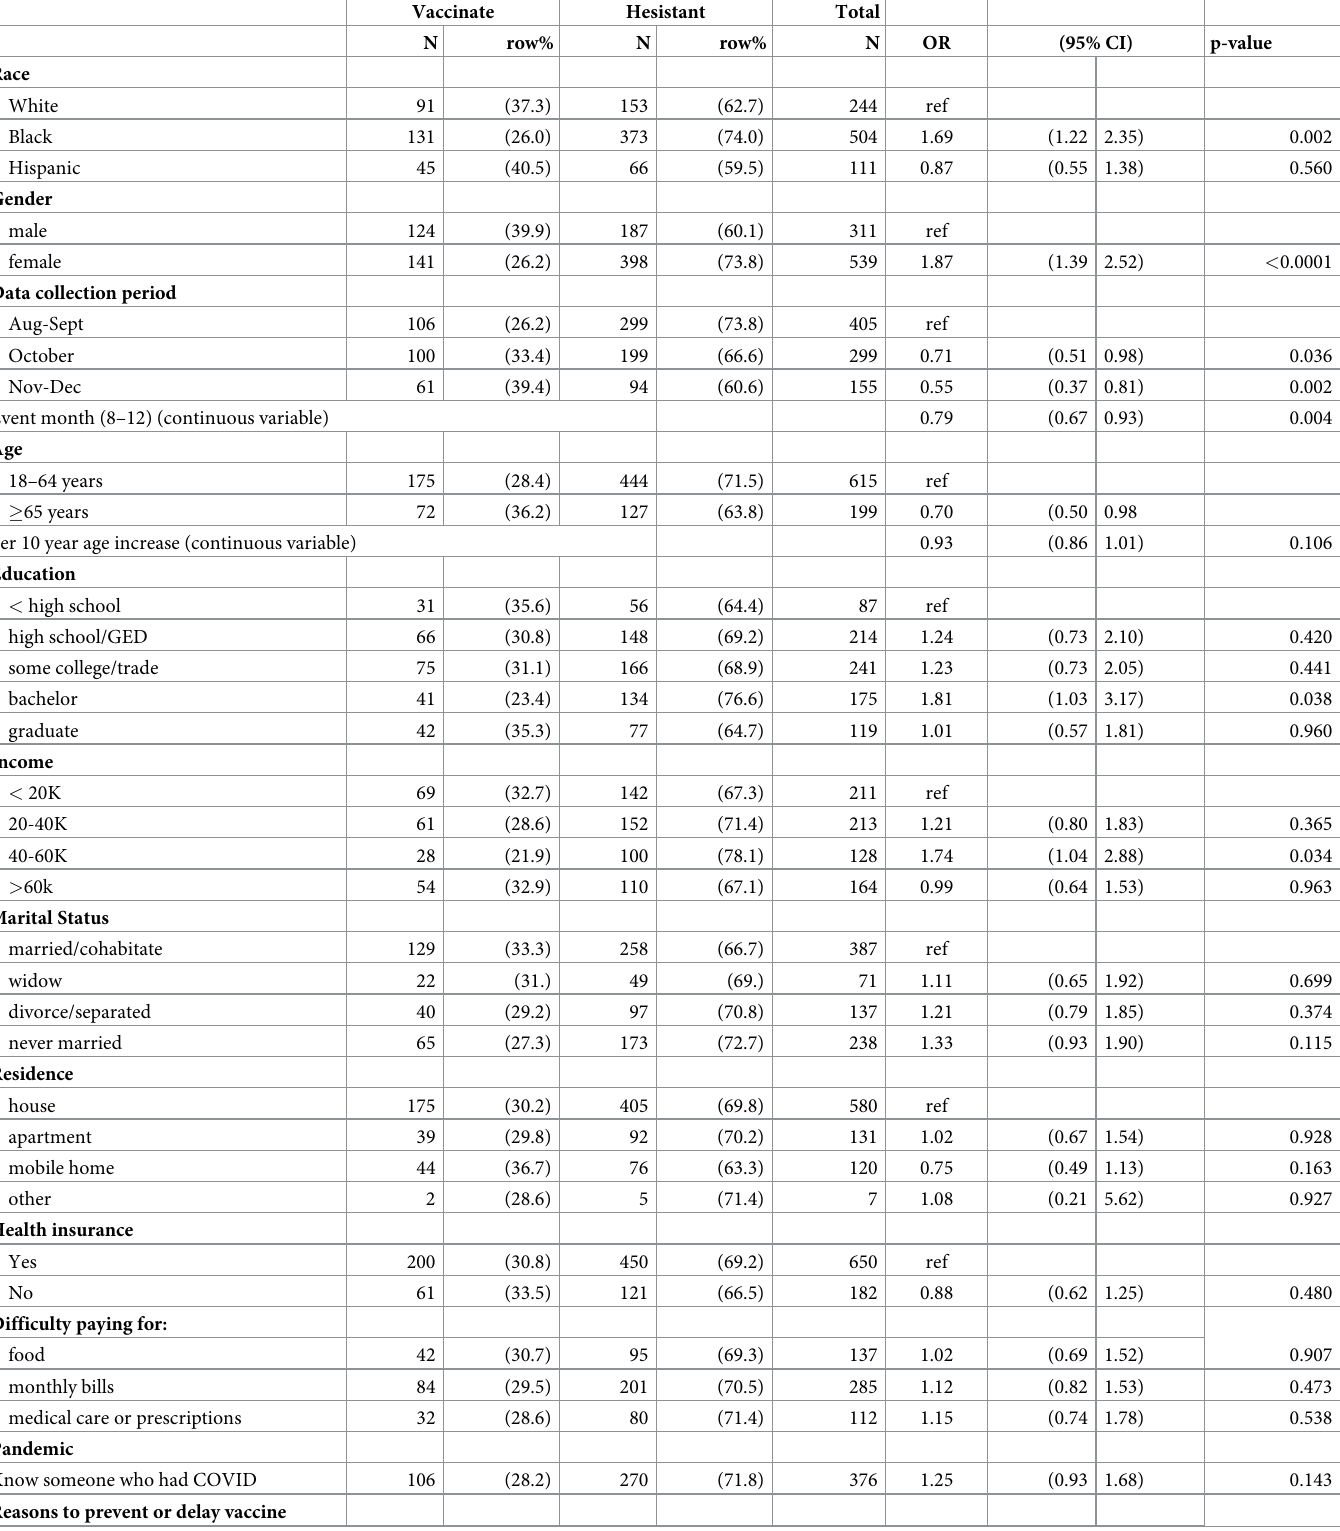
Table 3. Bivariate logistic regression—vaccine hesitancy, ACCORD study, NC August-December 2020.